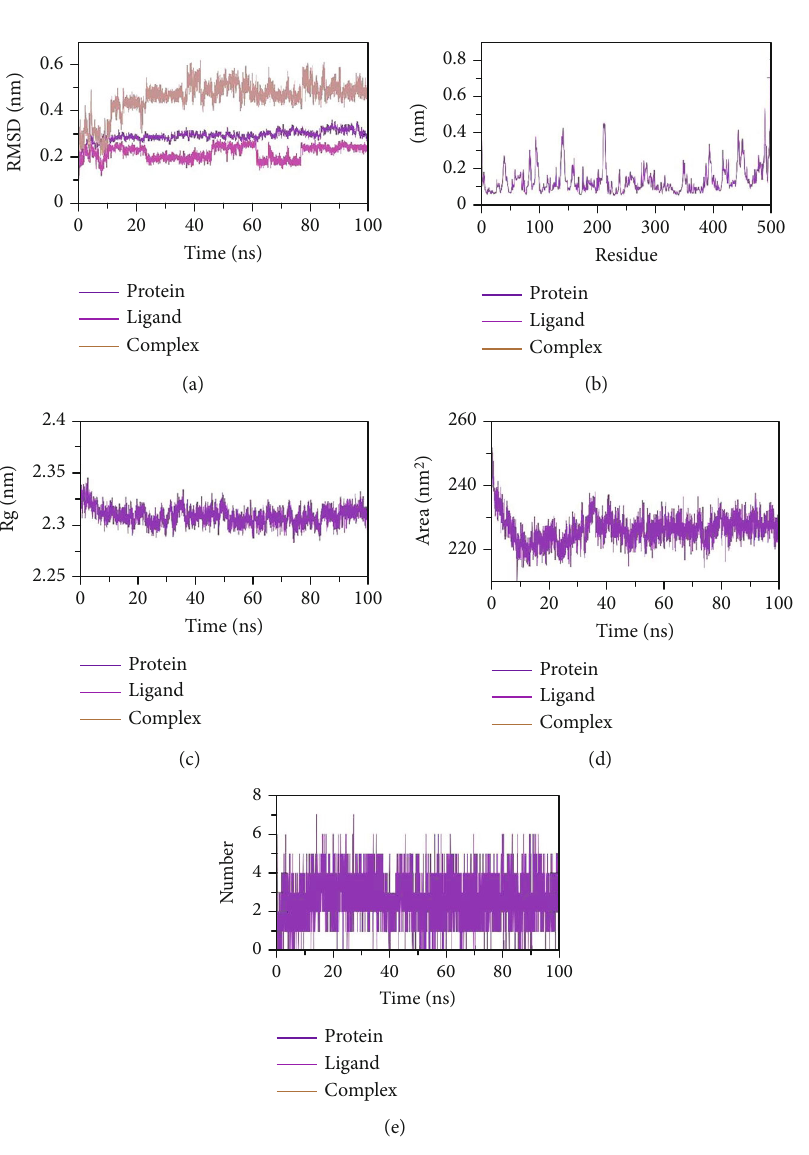
Figure 15: MD simulation trajectory analysis of (a) root mean square deviation (RMSD) of proanthocyanidin-B2 bound with 7T9K at 100- ns time frame, (b) root mean square fl uctuation (RMSF), (c) radius of gyration (Rg), (d) solvent accessible surface area plot of proanthocyanidin-B2 bound with 7T9K at 100-ns time frame, and (e) number of H-Bond plot of proanthocyanidin-B2 bound with 7T9K at 100ns time frame.